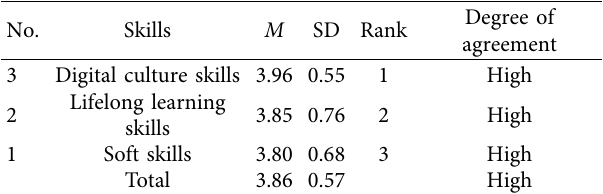
Table 9: Descriptives of the future skills that should be acquired by PSAU students to meet the requirements of the labor